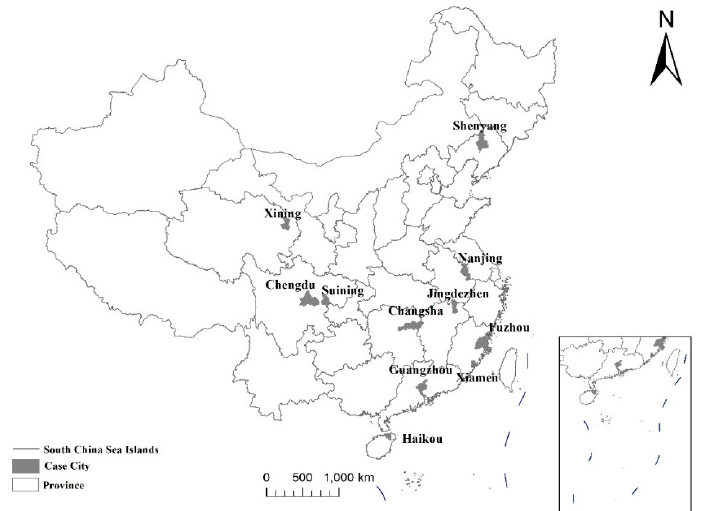
Figure 2. Location of the study area cities in China.